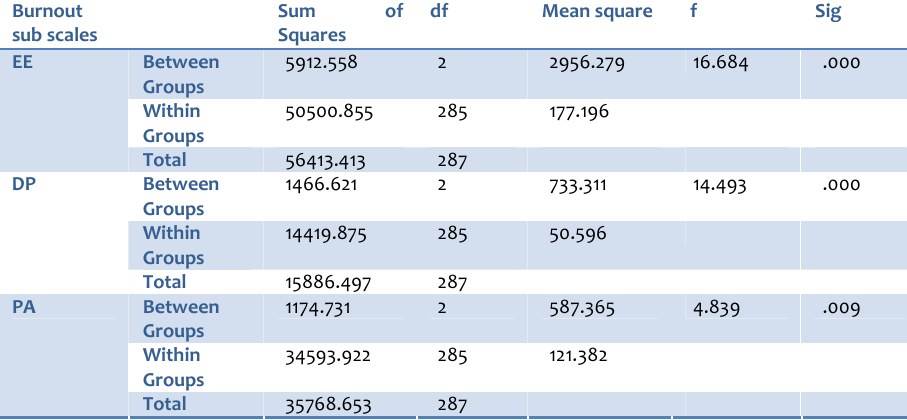
Table 14: Respondents’ Plan to Leave Work and Mean Score of Burnout Burnout sub